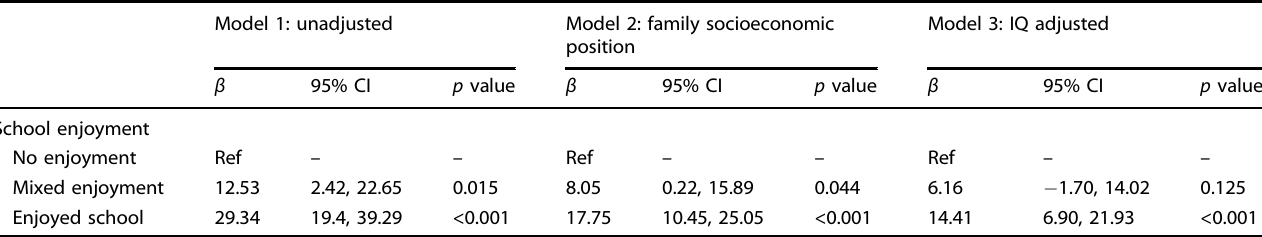
Table 3. Linear regression of age 16 GCSE achievement (capped points score) on key parameters in multiple imputation sample. Full parameter estimates provided in Supplementary Table 4. Model 1: unadjusted